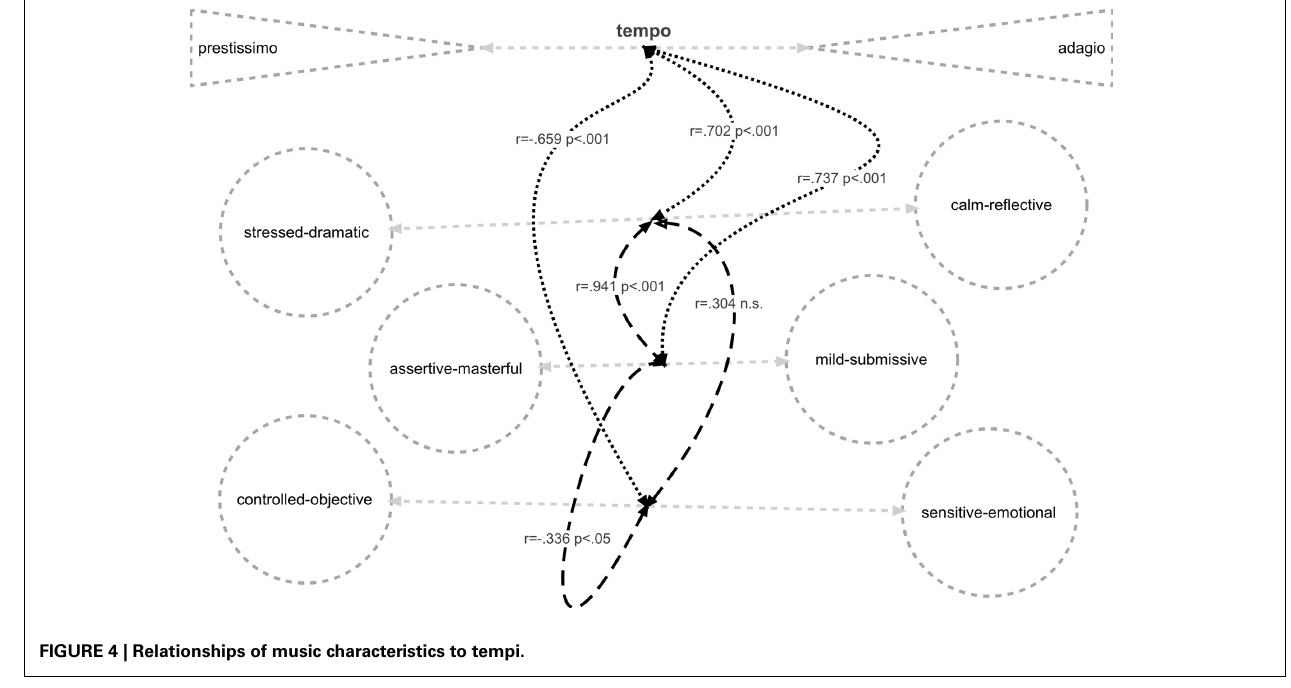
FIGURE 4 | Relationships of music characteristics to tempi.